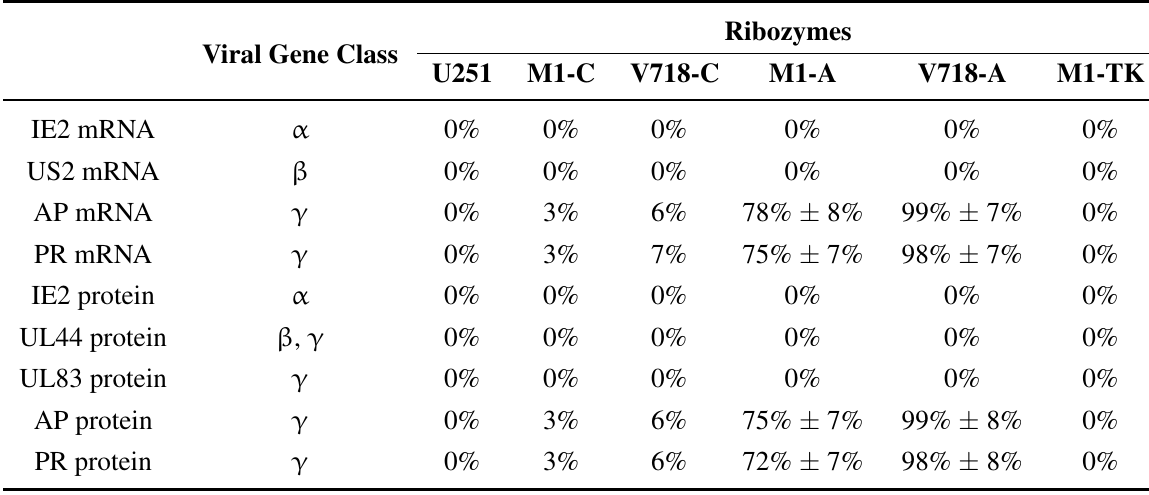
Figure 3. Northern blot analyses of the expression levels of HCMV mRNAs. RNA samples (30 µg) were isolated from HCMV-infected parental U251 cells (-, lanes 1, 5, 9, and 13) and cell lines expressing M1-C (lanes 2, 6, 10, and 14), M1-A (lanes 3, 7, 11, and 15), and V718-A (lanes 4, 8, 12, and 16) at 8 h ( C ) and 48 h post-infection (( A ), ( B ), and ( D )). The hybridized probes were used to detect the HCMV 5 kb RNA (lanes 1–4), AP/PR mRNA (lanes 5–8), IE2 mRNA (lanes 9–12), and US2 mRNA (lanes 13–16). Table 2. Inhibition Levels of HCMV mRNA and protein expression in the cells with M1GS, as compared with parental U251 cells.